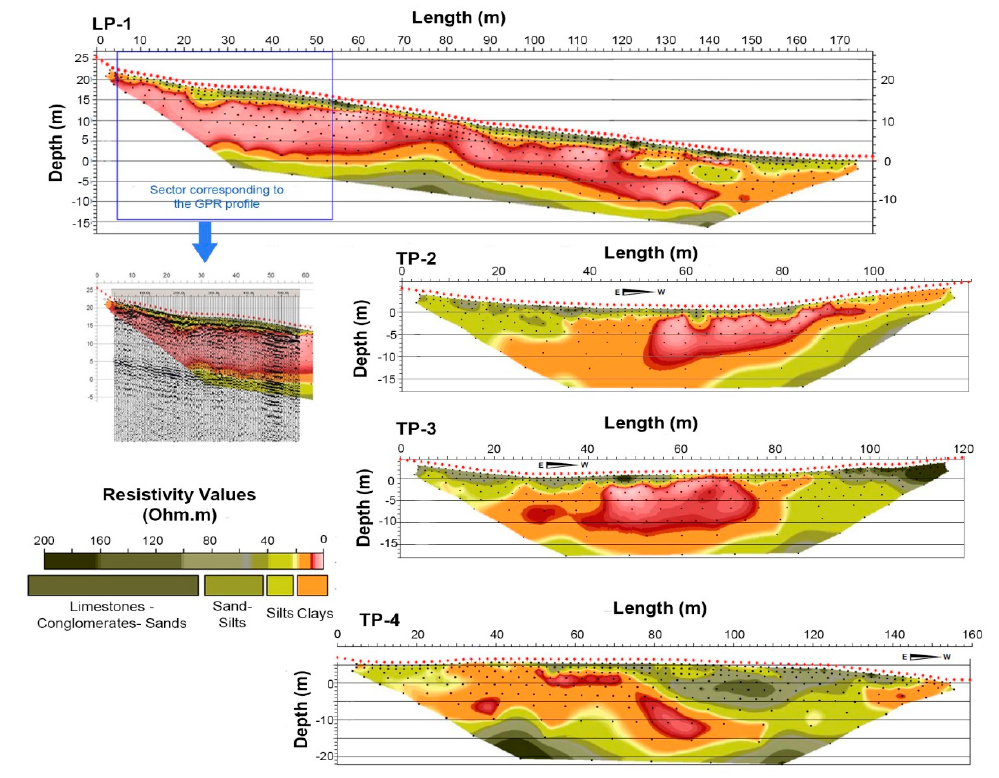
Figure 7. Resistivity sections for electrical resistivity tomography (ERT) profiles at the Diezma landslide. The tomography study was performed in the winter season.